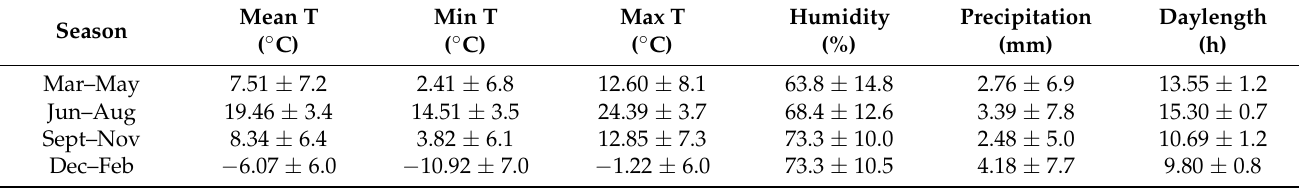
Table 1. Average daily meteorological conditions according to season during the trial